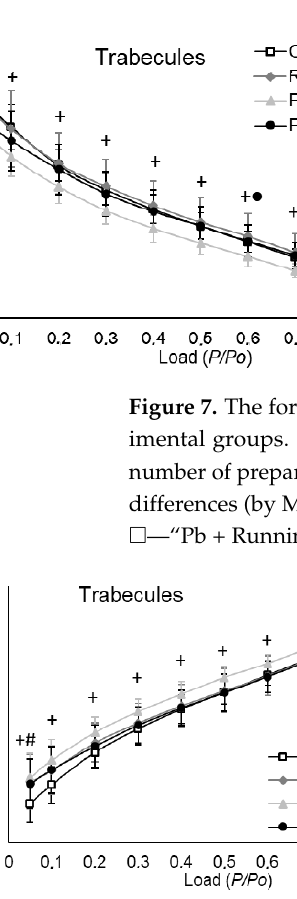
Figure 8. The end-systolic length–afterload relationships of trabecules ( A ) and papillary muscles ( B ) in the experimental groups. The number of preparations is given in brackets. Data are